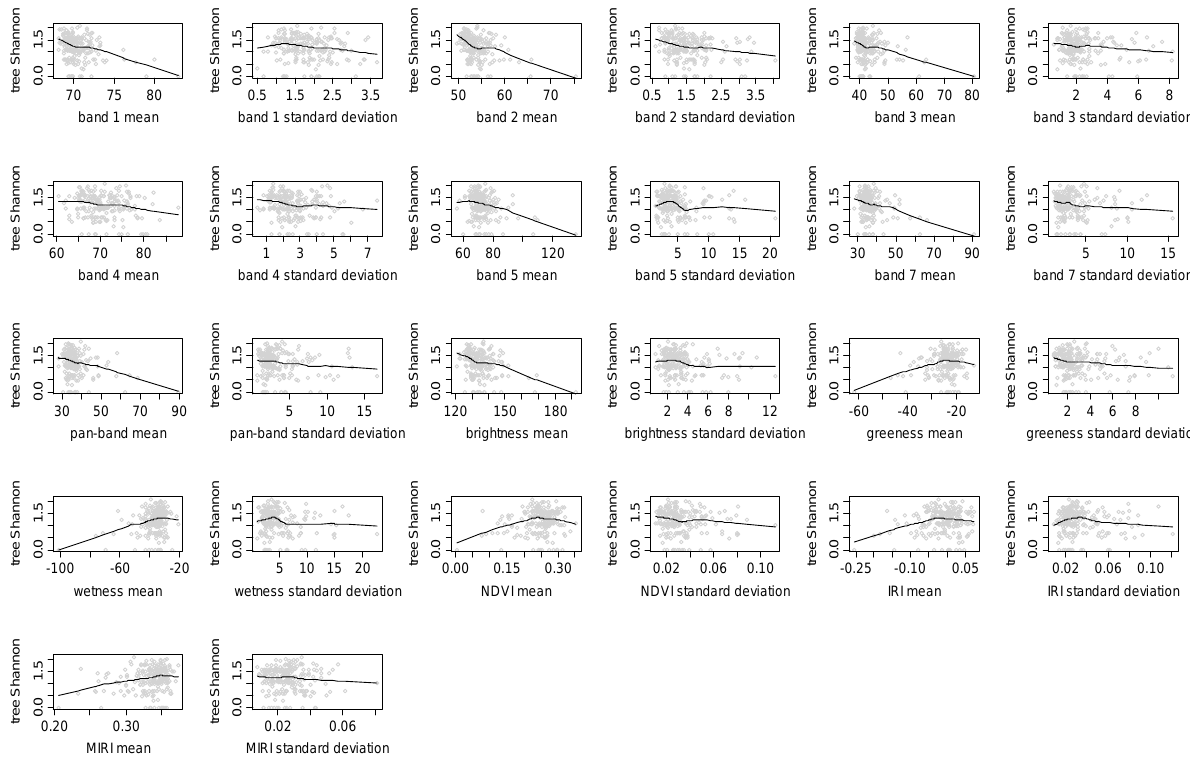
Figure 4. Scatterplots of tree Shannon diversity vs. Landsat ETM+ spectral variables Fitted curves represent LOWESS based smoothing.